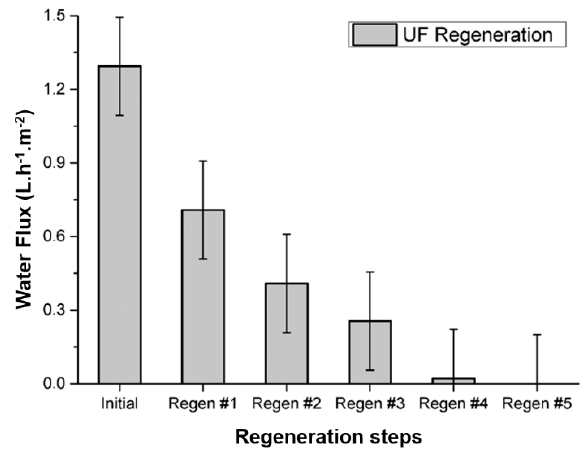
Figure 9. Generated water flux in successive FO/UF cycles with a 12.9 g·L − 1 ionosilica hydrogel dispersion.